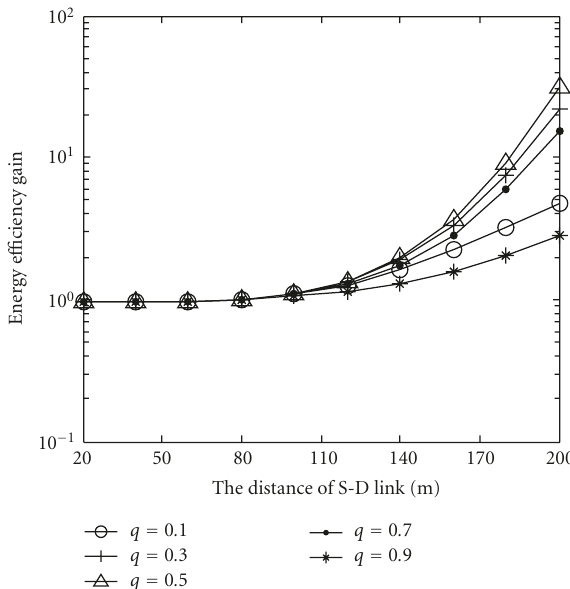
Figure 3: Energy e ffi ciency gain versus the S-D distance for di ff erent relay locations.